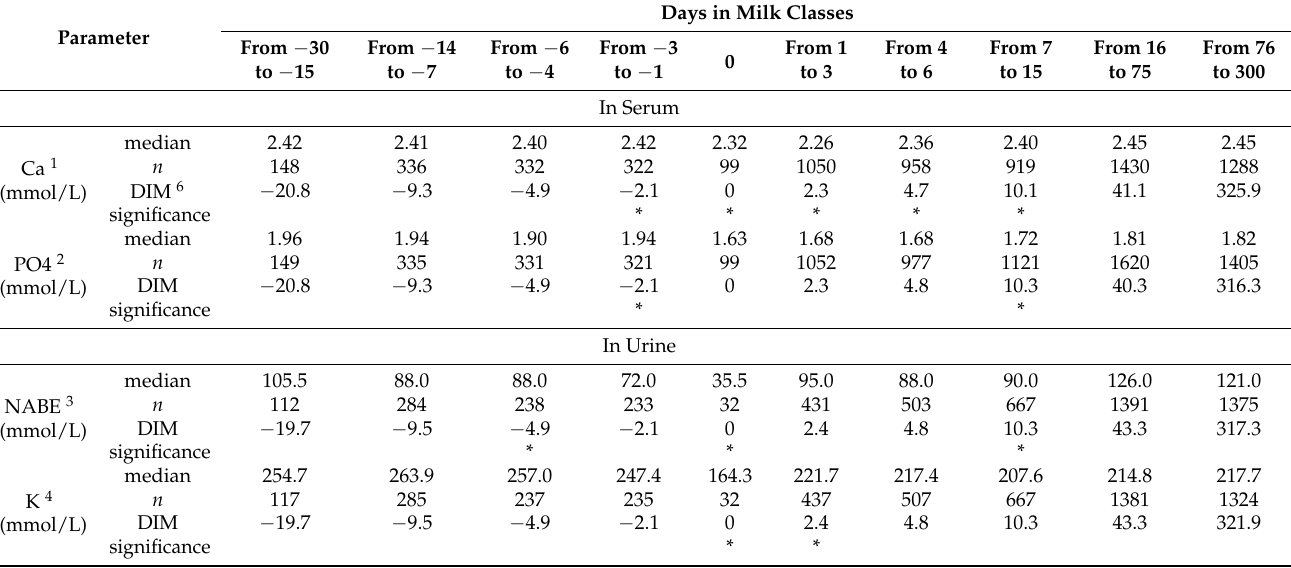
Table A5. Parameters of mineral status and acid base metabolism in serum and urine in ten DIM classes in primiparous